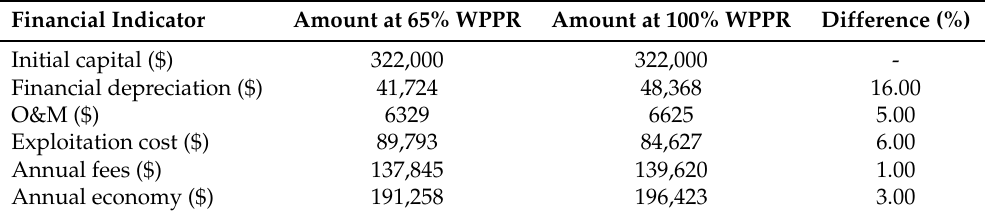
Table 10. Cost summary at 65% and 100% WPPR.